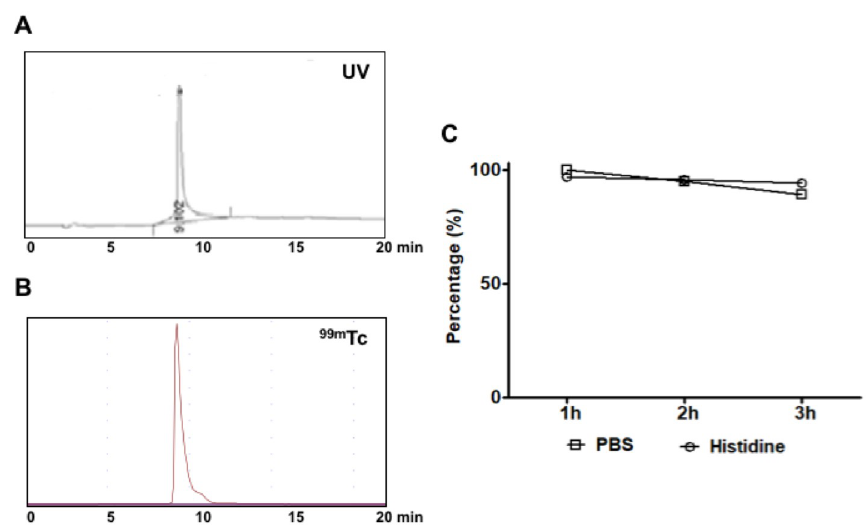
Fig 3. RP-HPLC analysis and stability. (A) RP-HPLC analysis of PAMAM G5 dendrimer-mannose-Cy7-HYNIC-Tfa UV ( λ = 214) detector, the retention time was 9.10 min. (B) RP-HPLC analysis of radiolabeled 99m Tc-HYNIC- dendrimers-mannose-Cy7, the retention time was 9.20 min. (C) Stability of 99m Tc-HYNIC-dendrimers-mannose-Cy7 versus histidine and PBS. 100% was the total activity of the compound determined at time 0, n = 3 for each point on the graph.